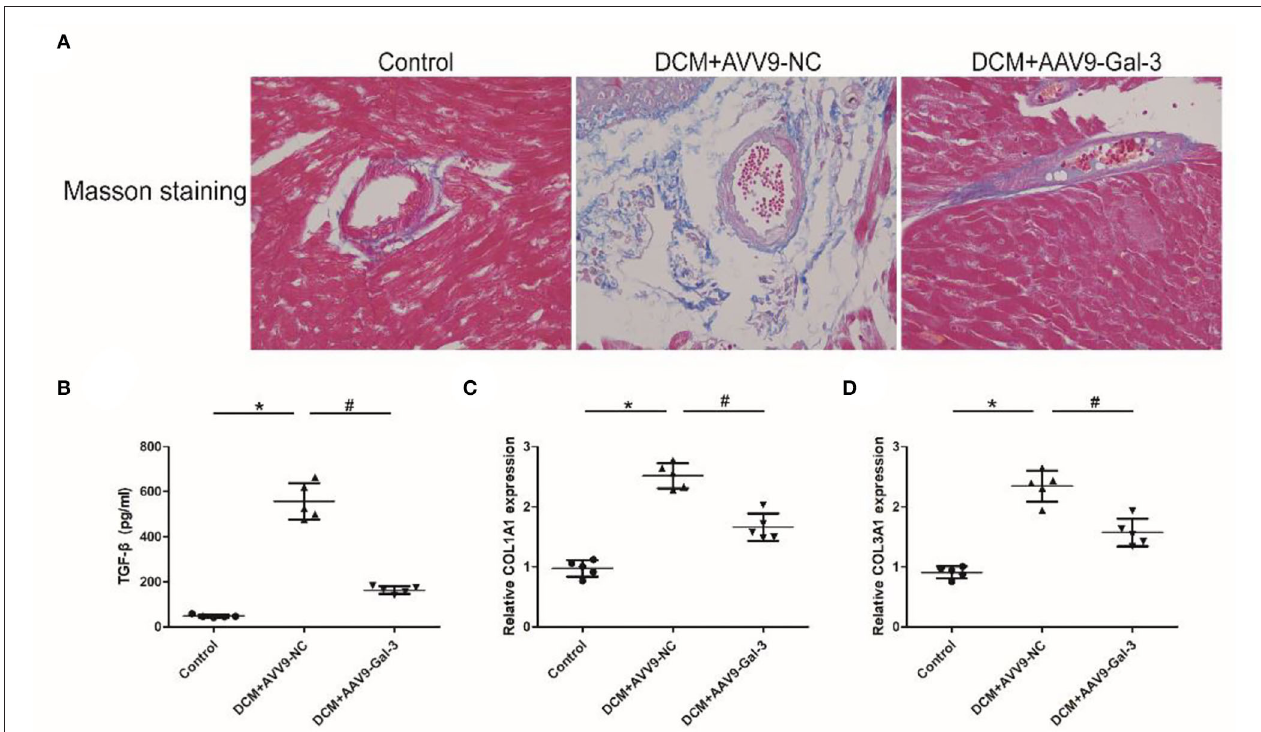
FIGURE 3 | Gal-3 inhibition attenuated diabetes-induced cardiac fibrosis (A) Masson staining of heart tissue at 16 weeks after STZ injection. Magnification, 200 × . (B) ELISA analysis of heart TGF- β expression. (C,D) Real-time PCR analysis of COL1A2 and COL3A1 mRAN level. Data are shown as mean ± SD. n = 5, * P < 0.05 vs. Control; # P < 0.05 vs. DCM +